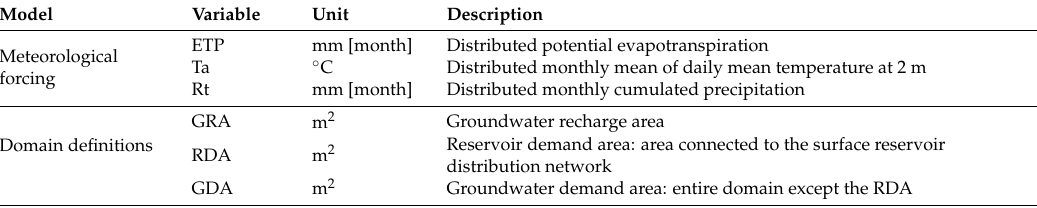
Table 1. Short description and nomenclature of meteorological forcings and impact model variables considered for this case study and described in details in